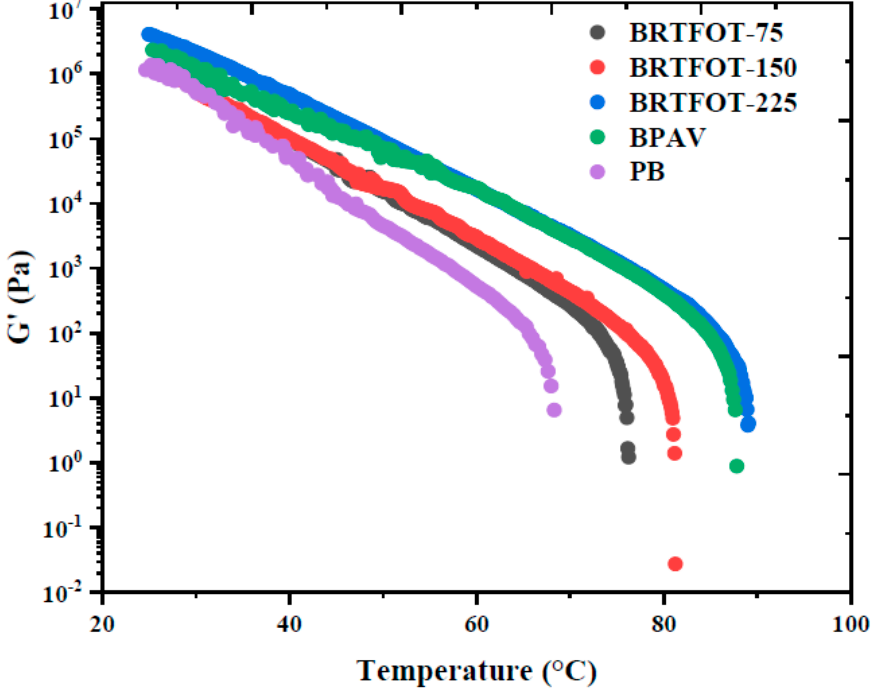
Figure 4. Temperature dependence (in the range 25 to 100 °C) of the elastic modulus for pristine and aged bitumen samples.